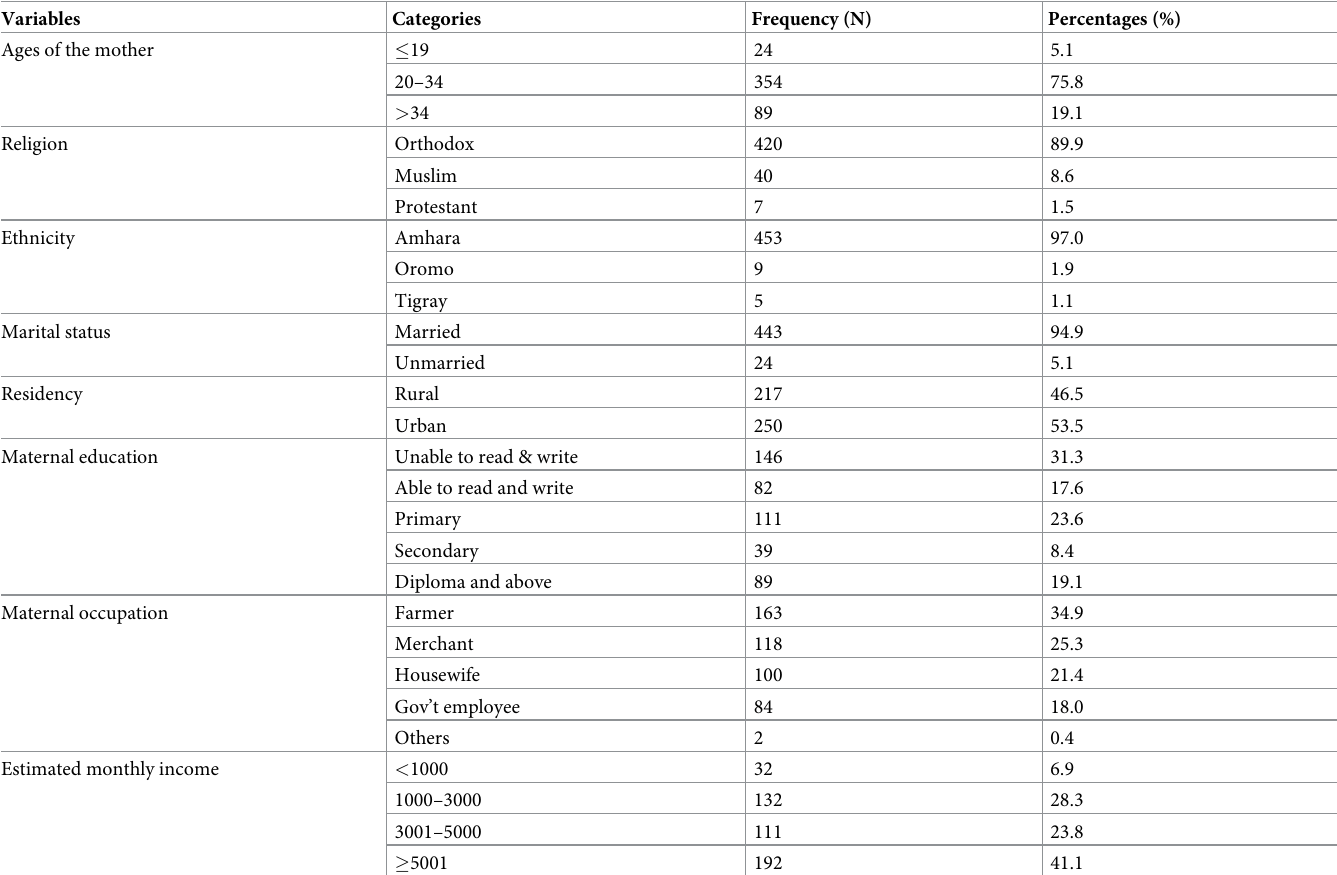
Table 1. Socio-demographic related characteristics of immediate postpartum women in East Gojjam zone hospital Northwest Ethiopia 2020 (n =